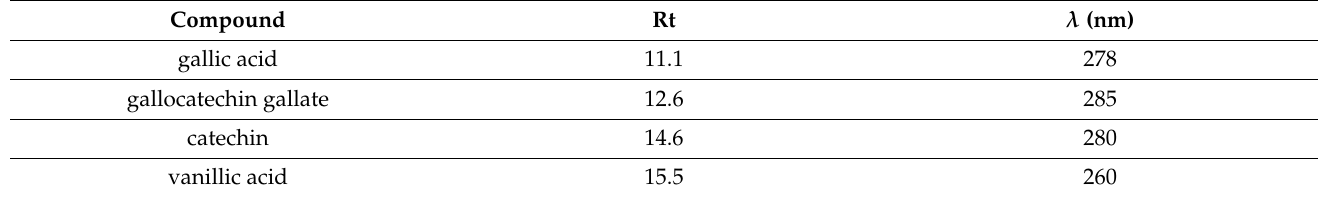
Figure 2. Characteristic chromatogram of a walnut sample spiked with a standard mixture at 2 μ g/g; monitored at 280 nm. Table 4. Retention time and maximum absorption wavelength of the phenolic analytes determined in walnuts.